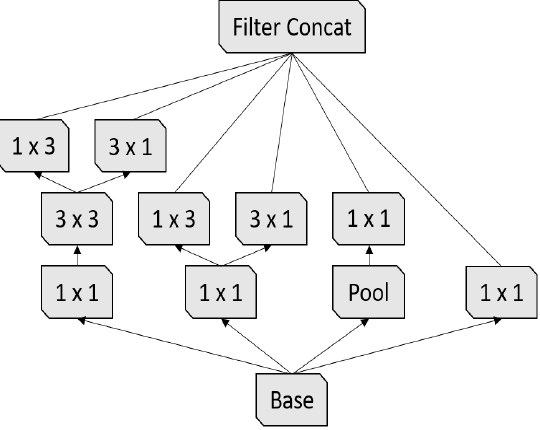
Figure 6. Third Inception module [17].